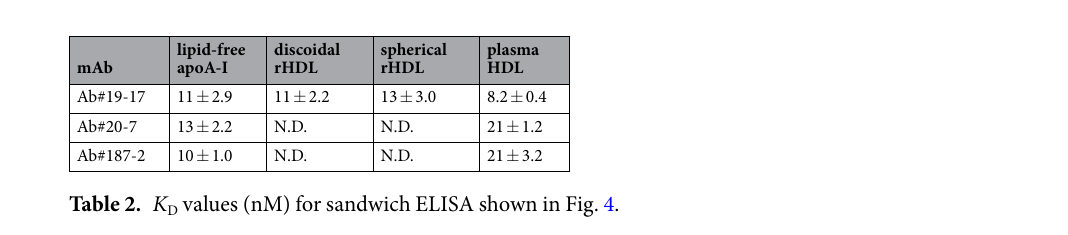
Figure 4. Sandwich ELISA for detection of lipid-free and HDL-bound apoA-I. ApoA-I in the lipid-free state ( A ), on reconstituted discoidal HDL ( B ) and spherical HDL ( C ), and human plasma HDL ( D ) were added to the plates coated with Ab#124-2. After washing, biotinylated Ab#19-17, Ab#20-7, or Ab#187-2 were added to the plates, and then detected with POD-conjugated streptavidin.